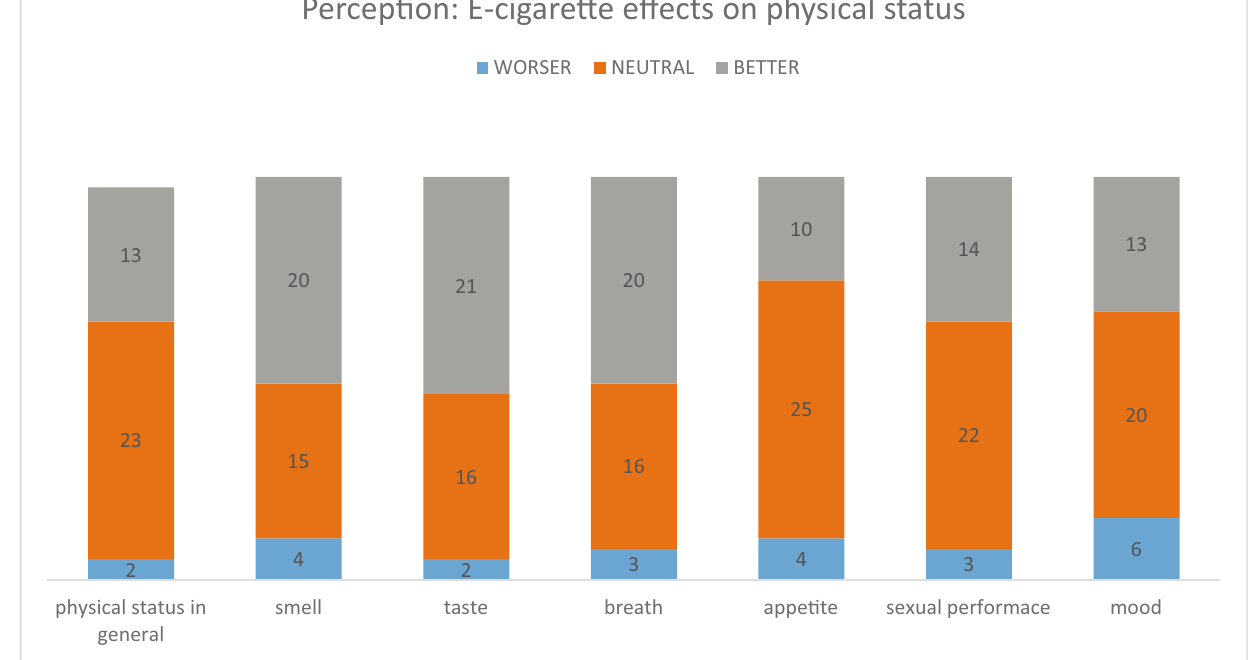
Figure 3: The perception of the physical status after the use of e -